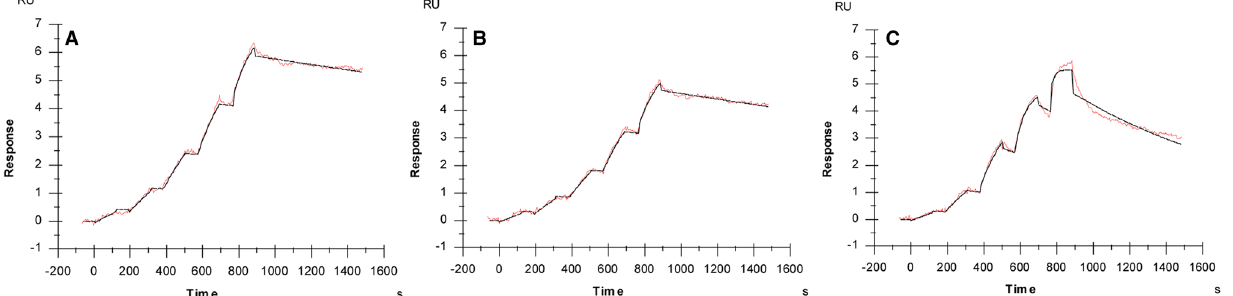
Figure 4. F84T Malay BanLec binds to HIV gp140 as determined by surface plasmon resonance. Single cycle kinetics of WT Malay BanLec ( a ), F84T Malay BanLec ( b ) and GRFT ( c ) binding to gp140. The concentrations of the injected lectins ranged from 0.63 to 10 nM for WT and F84T Malay BanLec and from 0.12 to 10 nM for GRFT. The red lines indicate the actual response measured during the experiment; the black lines indicate the 1:1 Langmuir model fitting. WT and F84T Malay BanLec bind 4 and 8 times slower, respectively, to the gp140 trimer than does GRFT and dissociate 5 and 3 times slower, respectively, than does GRFT. The binding avidities, K D , of WT Malay BanLec, F84T, and GRFT are 1.22 ± 0.62, 3.68 ± 0.41, 1.37 ± 0.35 (10 –10 ) (M), respectively.